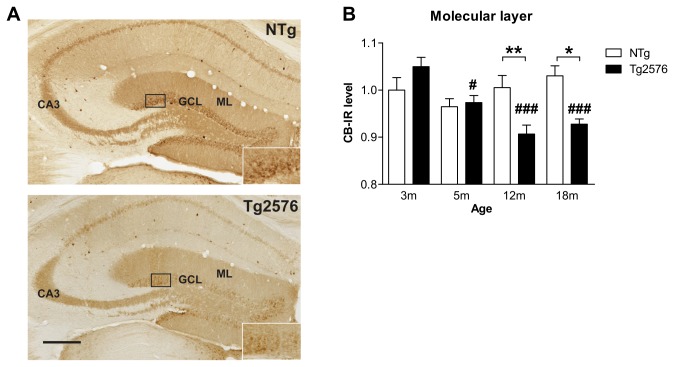
Late depletion of calbindin expression in dentate gyrus of Tg2576 mice.(A) Brain sections of 12 month-old NTg and Tg2576 mice immunolabeled for calbindin (CB). (B) CB expression was evaluated in the molecular layer of the dentate gyrus and remained stable through the aging process in NTg mice (n=6-9 mice/group). In Tg2576 mice, CB expression decreased gradually with aging starting at 5 months compared to 3 month-old Tg2576. Compared to age-matched NTg mice, 12 and 18 month-old Tg2576 mice displayed strongly reduced CB expression. Quantitative data represent mean ± SEM in B. Data were analyzed by two-way ANOVA with Bonferroni post-hoc: #p<0.05; ###p<0.001 age effect for each genotype; *p<0.05; **p<0.01 Tg2576 mice vs age-matched NTg, two-way ANOVA. ML: molecular layer, GCL: granular layer. Scale bar: A=250µm.